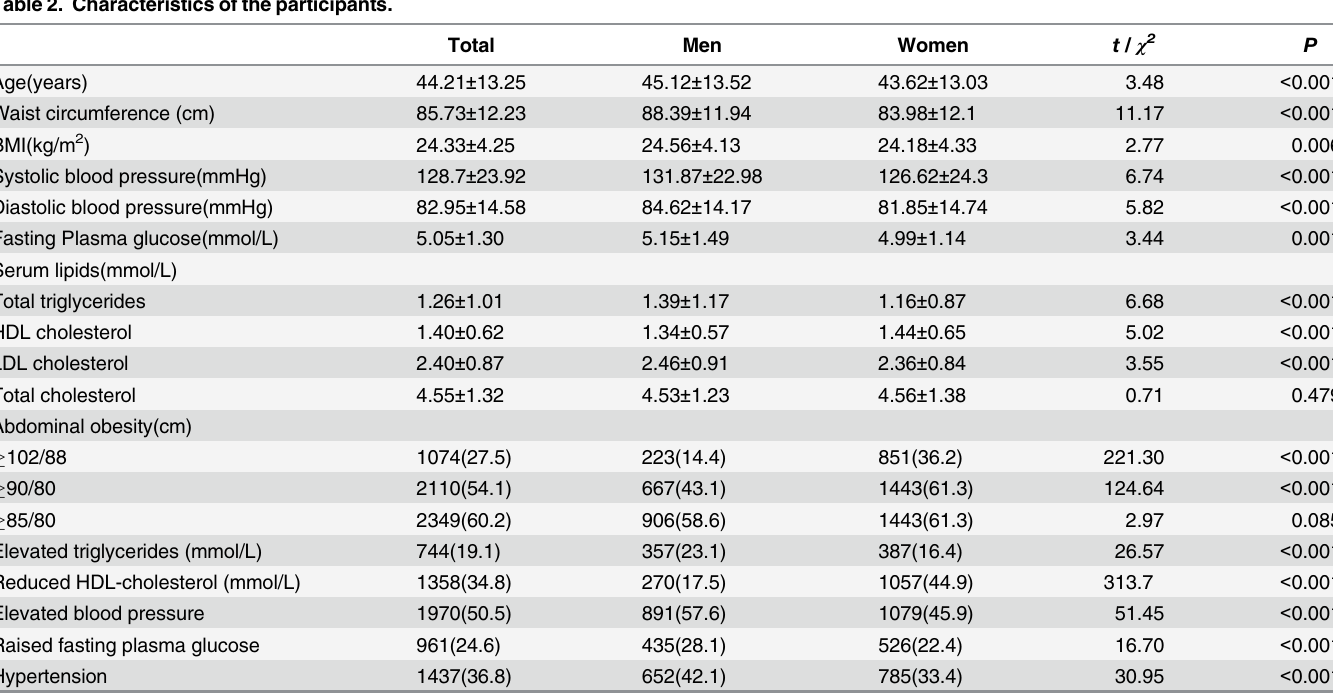
Table 2. Characteristics of the